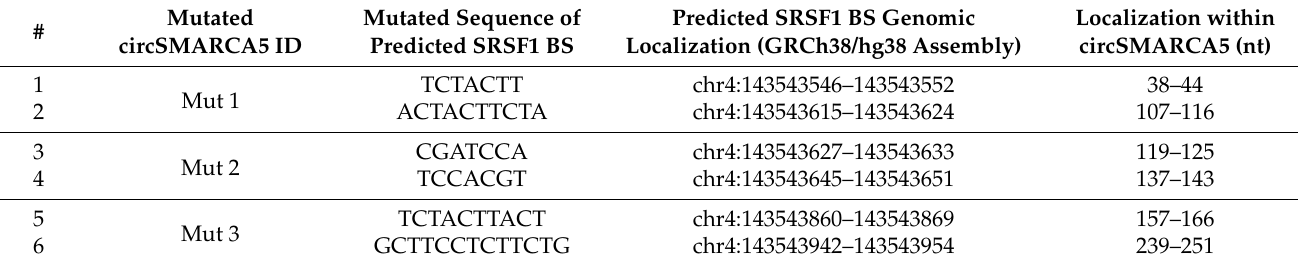
Figure 1. Schematic representation of wild-type (WT) and mutated circSMARCA5 sequences. The inner circle represents the whole WT circSMARCA5 sequence: predicted SRSF1 BSs are highlighted in bold, using different colors. In the outer arches mutated SRSF1 BSs are indicated in italics. Table 1. Sequence, genomic localization and nucleotide (nt) position of mutated Serine and Arginine Rich Splicing